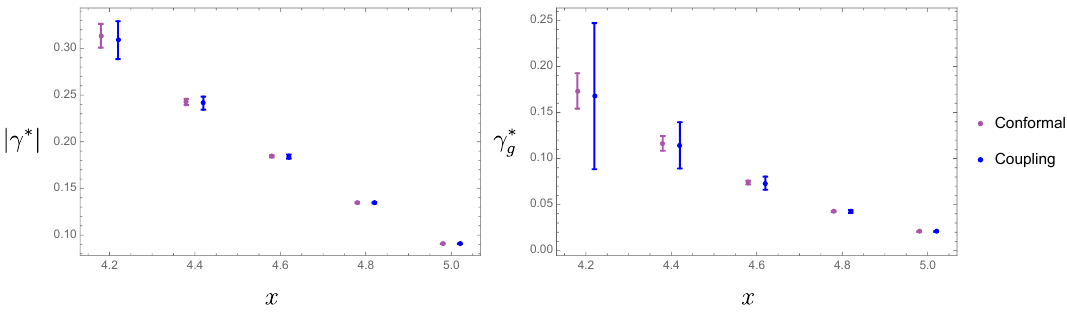
Figure 6 . Values of j (cid:13) (cid:3) j (left) and (cid:13) (cid:3) (right) as a function of x = n f =n c in the Veneziano limit. g The central values and error bars refer to the Pad(cid:19)e-Borel approximants [0 = 3] in the conformal expansions and [2 = 2] in the coupling expansion for both j (cid:13) (cid:3) j and (cid:13) (cid:3) . In both panels and for both g ordinary coupling and conformal expansions the error bars correspond to c np =